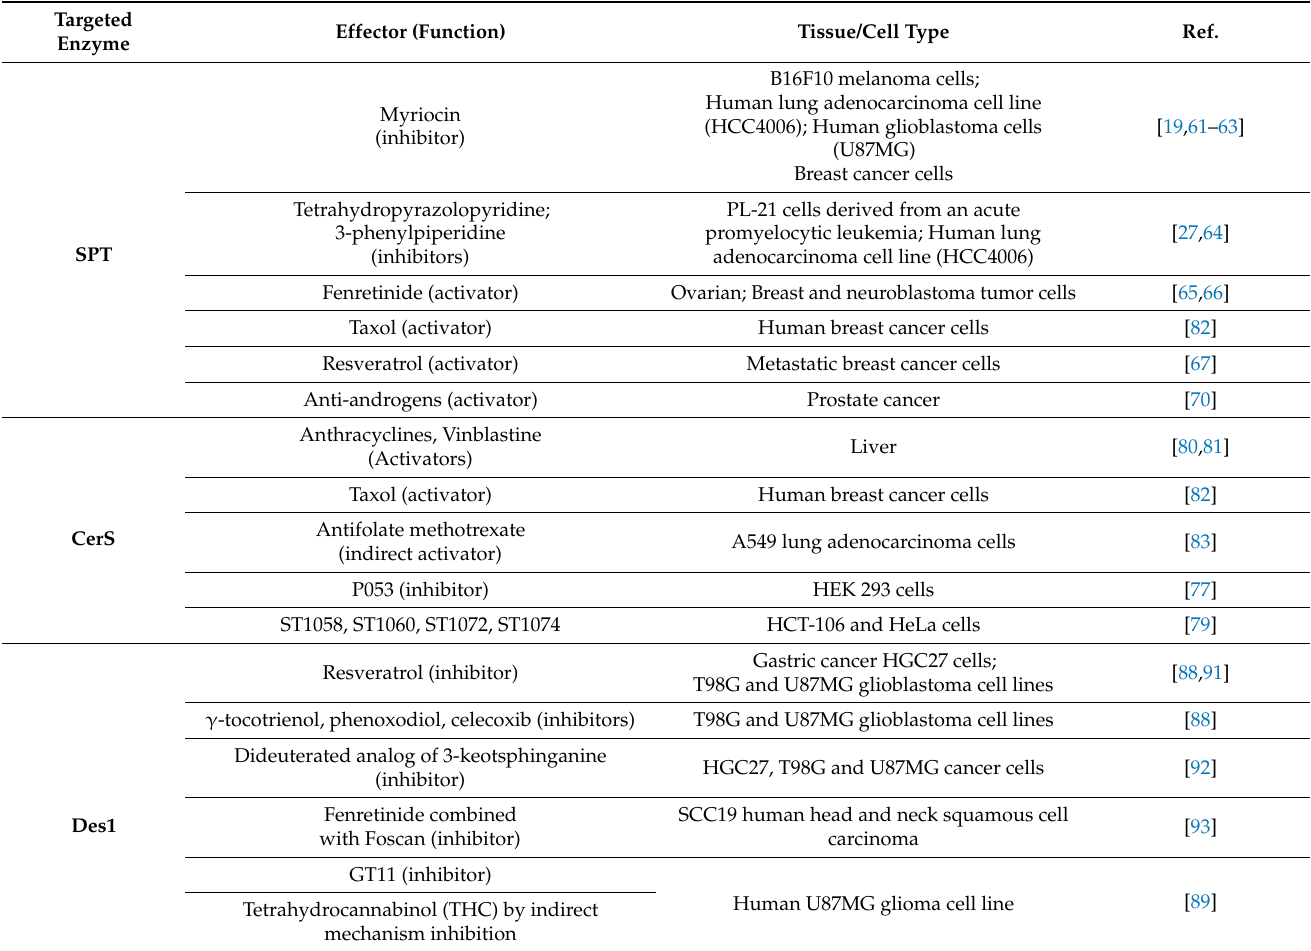
Table 1. Enzyme inhibitors and activators that efficiently alter ceramide metabolism. Targeted Effector (Function) Tissue/Cell Type Enzyme